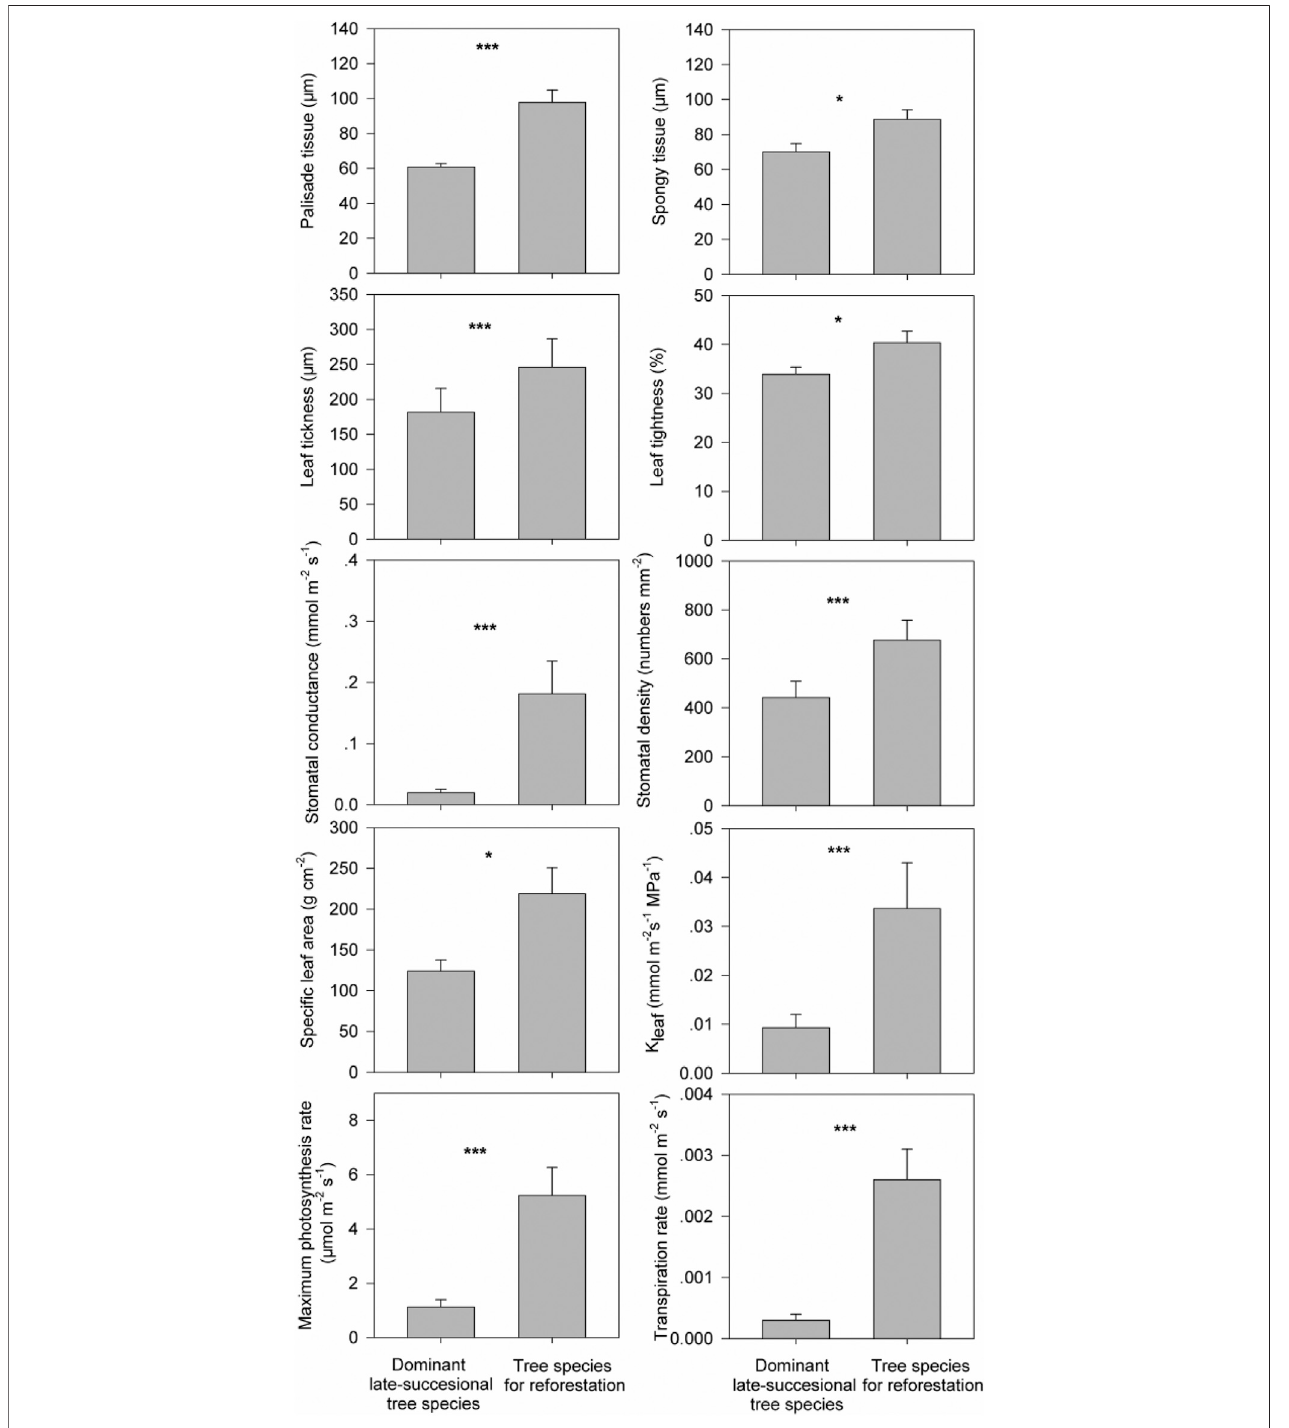
FIGURE 3 | Differences in ten functional traits associated with a fast-growth strategy (i.e., palisade tissue (PT; μ m), spongy tissue (ST; μ m), leaf thickness (LT; μ m), leaf tightness (LTI; %), stomatal conductance (SD; mmol m − 2 s − 1 ), stomatal density (numbers mm − 2 ), speci fi c leaf area (SLA; g cm − 2 ), leaf hydraulic conductivity (k leaf ; mmol m − 2 s − 1 MPa − 1 ), maximum photosynthesis rate (A mass ; μ mol m − 2 s − 1 ) and transpiration rate ( μ mol m − 2 s − 1 )) between the eight separately monocultured fast- growing tropical tree species used for reforestation (tree species for reforestation) and the eight dominant tropical tree species in the undisturbed old-growth tropical rainforest (dominant late-successional tree species). *** indicates p < 0.001 based on Wilcoxon signed-rank tests.